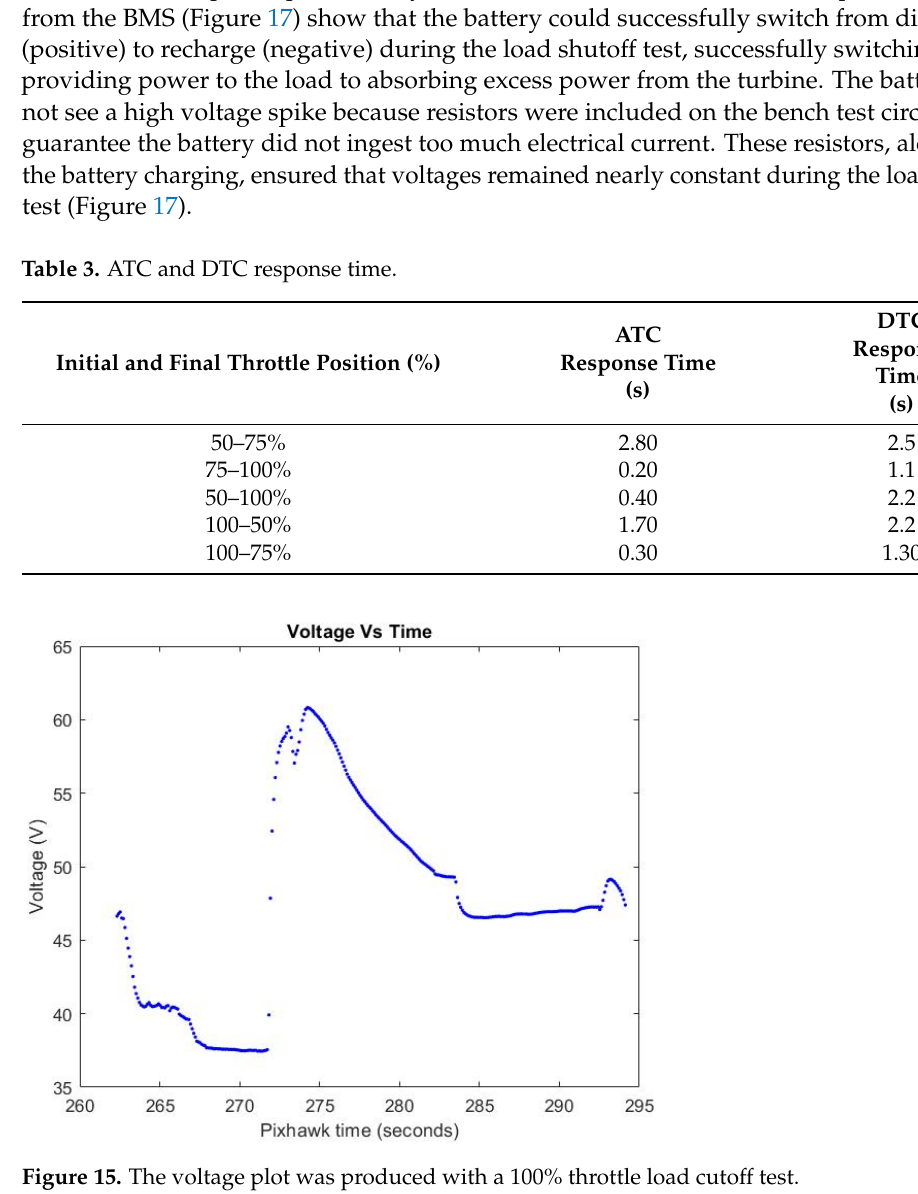
Figure 16. Voltages produced by the turboelectric system in ATC with negative throttle steps.